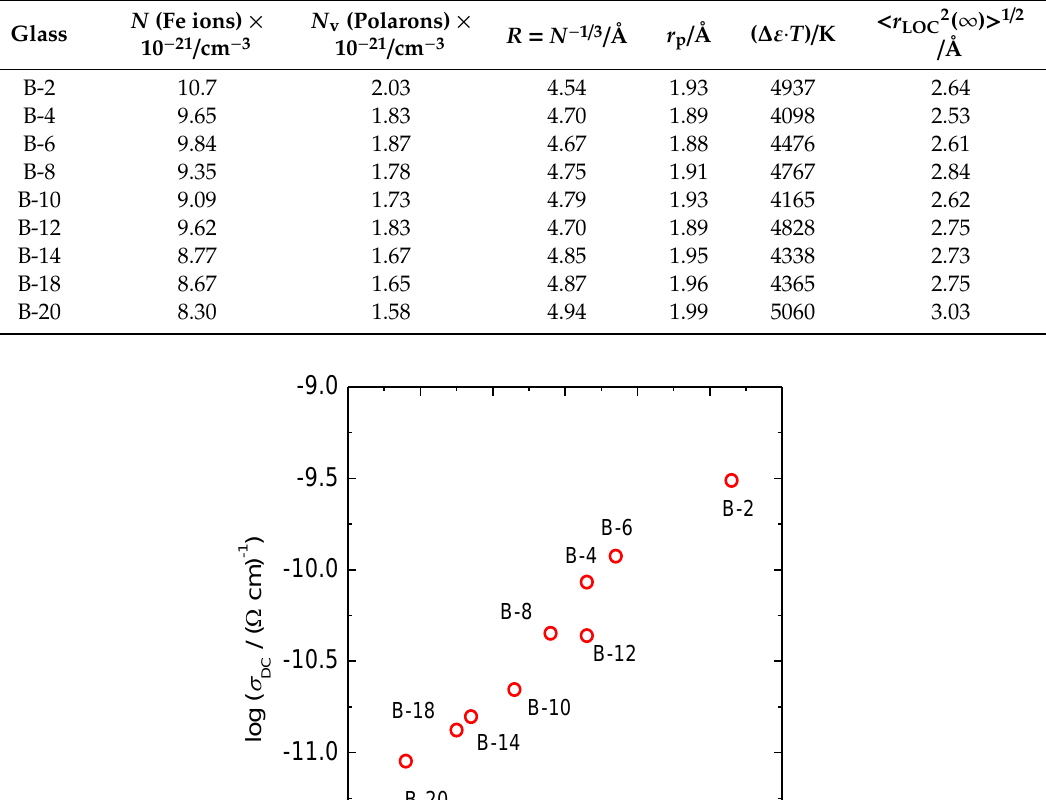
Table 3. Summary of quantities and parameters of polaronic transport for glasses from x B 2 O 3 –